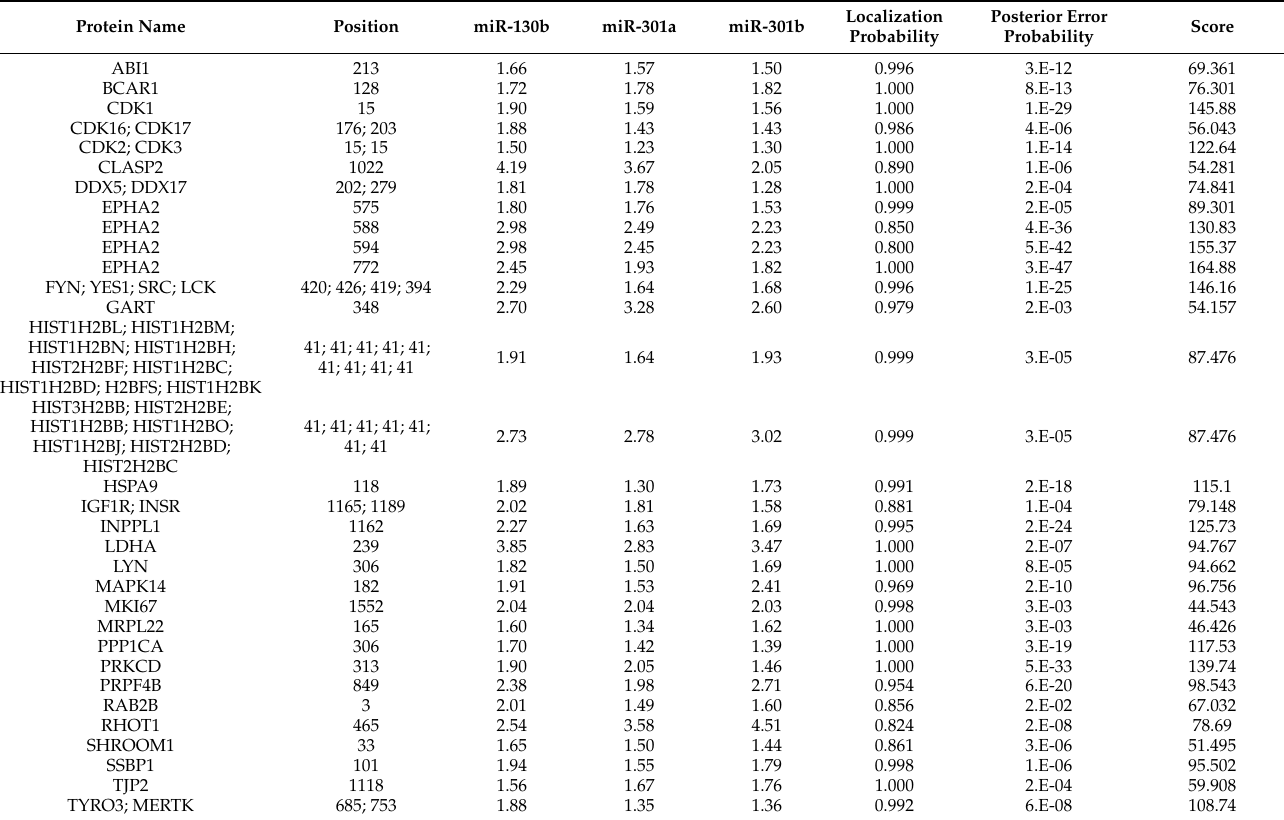
(Supplementary Figure S4). Proto-oncogene tyrosine-protein kinase Src functions as the hub of a vast array of signaling pathways [14]. Although, the miR-130 family mimics had no significant effect on phosphorylation levels of epidermal growth factor receptor (EGFR Tyr1068 , Supplementary Figure S5), the miRNA mimic targeting the miR-130 family upregulated the phosphorylation levels of Src Tyr416 (Figure 2A, Table 1) and its downstream effector molecule Akt (Akt Ser473 and Akt Thr308 ) in UM-UC-2 cells (Figure 2B). On the other hand, miR-130F LNA inhibited the phosphorylation levels of Src and Akt in 5637 cells (Figure 2C), suggesting that the miR-130 family functions as an oncomiR by targeting vari- ous tumor-promoting pathway through Src phosphorylation, and miR-130F LNA could inhibit the downregulation of Src phosphorylation in bladder cancer cells. Table 1. Tyrosine-phosphorylated proteins upregulated by miR-130 family